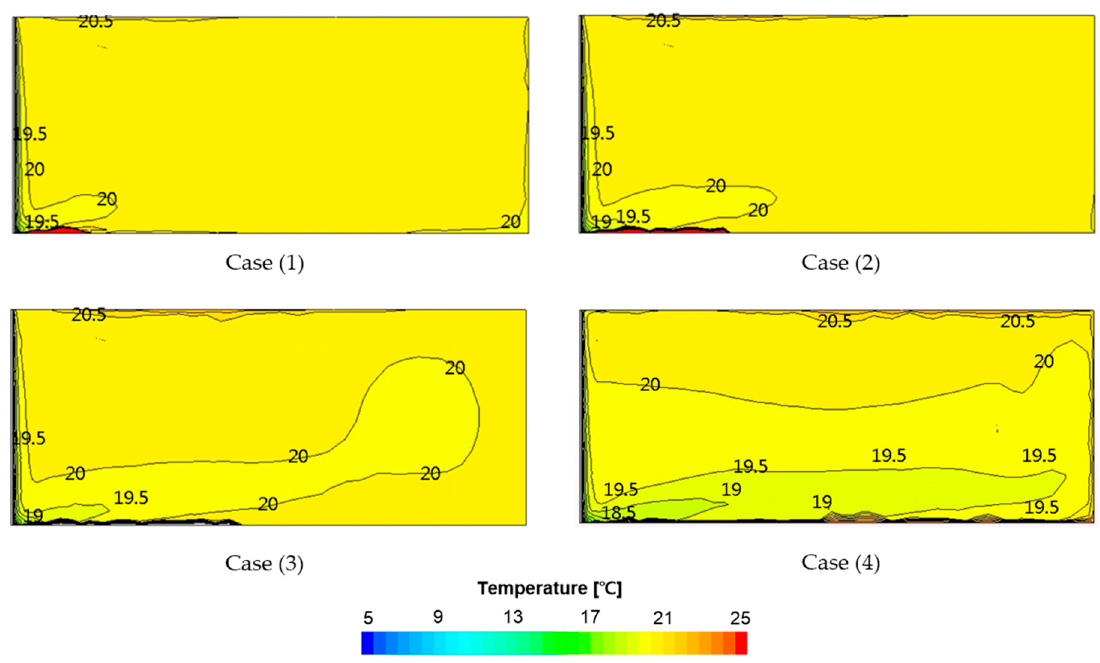
Figure 8. Velocity profiles.